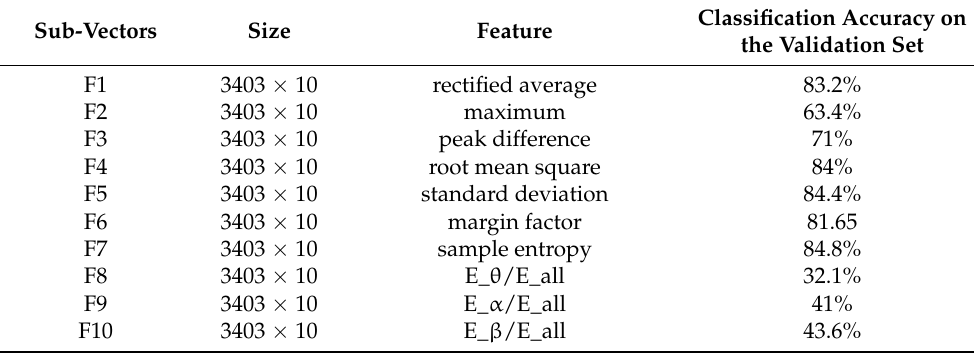
Table 5. Classification accuracy of each feature on the validation set.